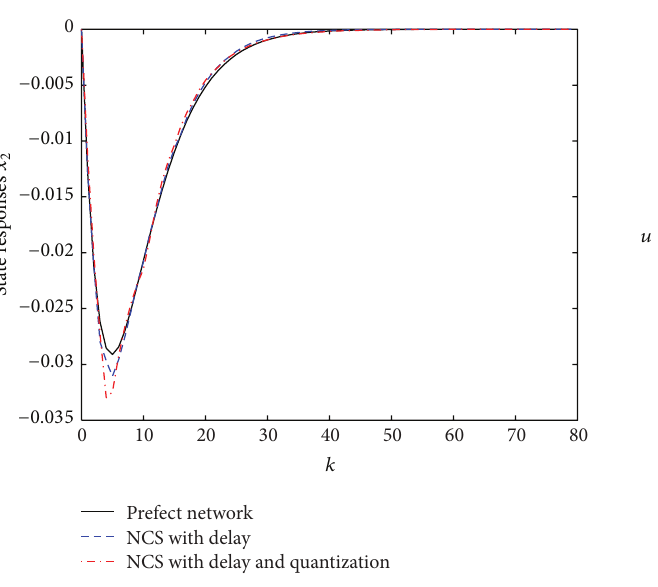
Figure 13: The state responses 𝑥 2 (Example 2).